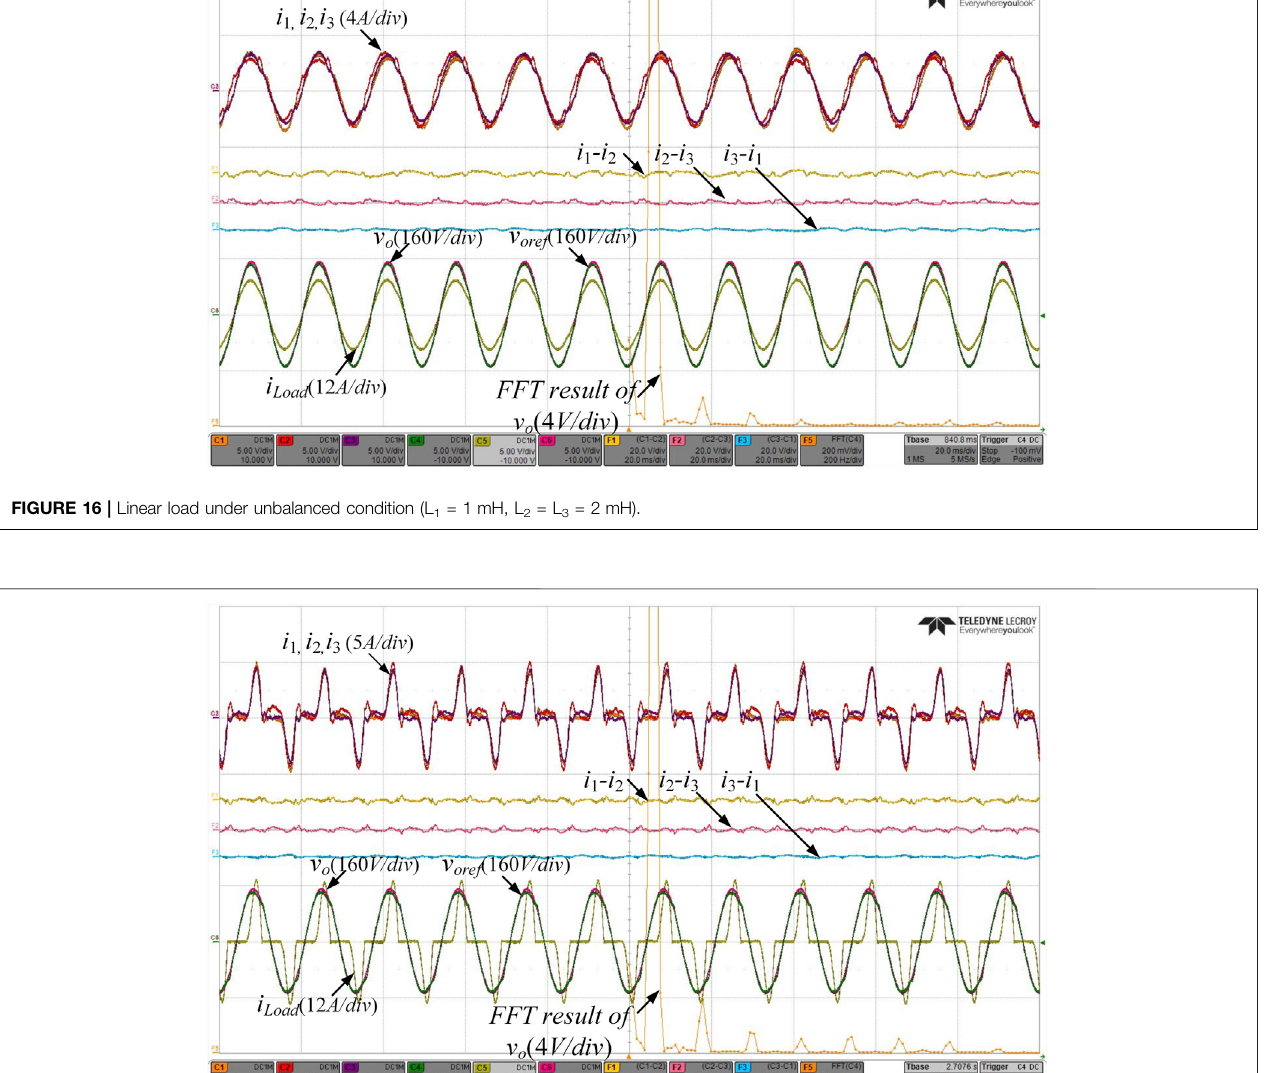
Frontiers in Energy Research |